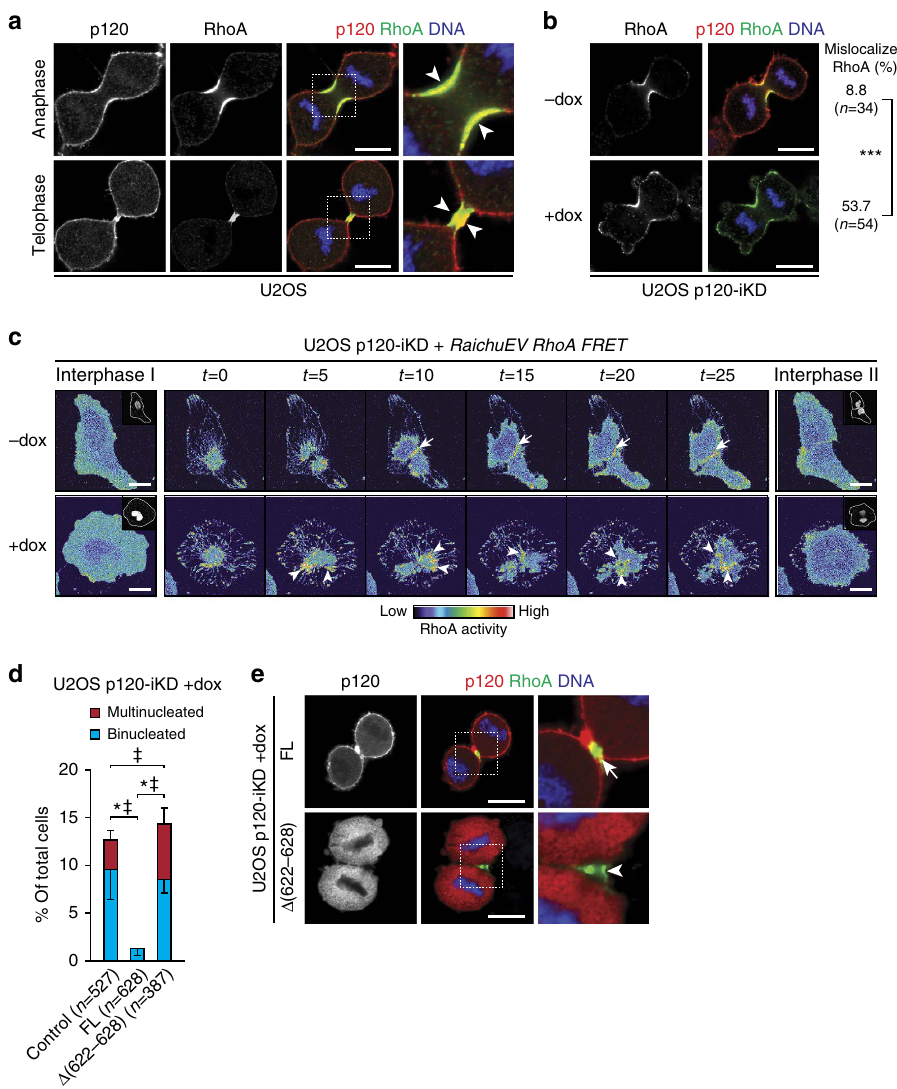
Figure 4 | p120 regulates RhoA activity on the equatorial cortex during cytokinesis. ( a ) IF for p120 and RhoA in anaphase and telophase U2OS cells. Note the accumulation of p120 and co-localization on the equatorial cortex (arrowheads). Right panels show magnifications of representative areas denoted by the dotted squares. Scale bar, 10 m m. ( b ) IF for p120 and RhoA in control and dox-treated U2OS p120-iKD cells. Scale bar, 10 m m. Quantifications show the percentage of control and dox-treated U2OS p120-iKD cells with RhoA-positive membrane protrusions during anaphase. *** P o 0.001. Statistical significance was determined using the w 2 -test. ( c ) Time-lapse stills of control and dox-treated U2OS p120-iKD cells expressing the RaichuEV RhoA FRET probe. Note the focused RhoA zone in control cells (upper panels; arrows), whereas RhoA activity is non-focused and oscillates in dox-treated U2OS p120-iKD cells leading to cytokinesis failure (lower panels; arrowheads). Insets show H2B-mCherry channels. Scale bar, 20 m m. ( d ) Quantification of bi- and multinucleation in dox-treated U2OS p120-iKD reconstituted with empty vector (control), FL p120-1A or the RhoA-binding mutant p120-1A D [622–628]. Statistical significance was determined using the Student’s t -test. Shown are the data from three independent experiments. Results are expressed as mean ± s.d. * P o 0.05/ z P o 0.05 (binucleation and multinucleation, respectively). ( e ) IF for p120 and RhoA in dox-treated U2OS p120-IKD cells reconstituted with FL p120-1A or p120-1A D [622–628]. Note the absence of co-localization of RhoA and p120 in p120-1A D [622–628]-expressing cells (arrowhead) compared with cells reconstituted with p120-A FL (arrow). Scale bar, 10 m